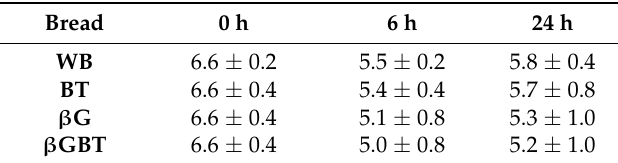
Table 3. Fermentation pH at 0, 6, and 24 h (mean +